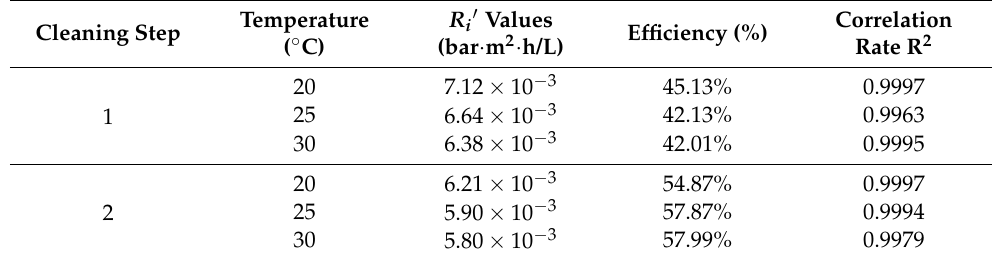
Table 5. Results obtained for the different phases of the cleaning protocol at each of the set temperatures.